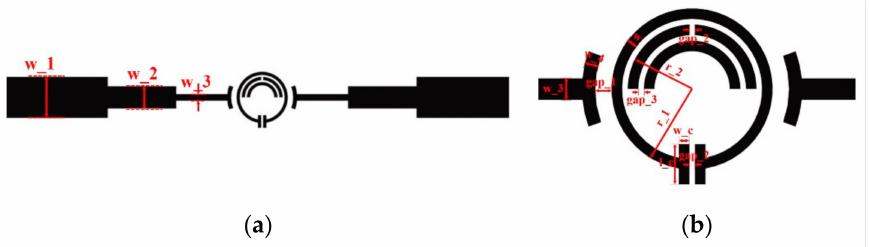
Figure 1. Structure of the proposed microwave sensor. ( a ) The full view of the microwave sensor; ( b ) the SRR structure and the sensing zone of the